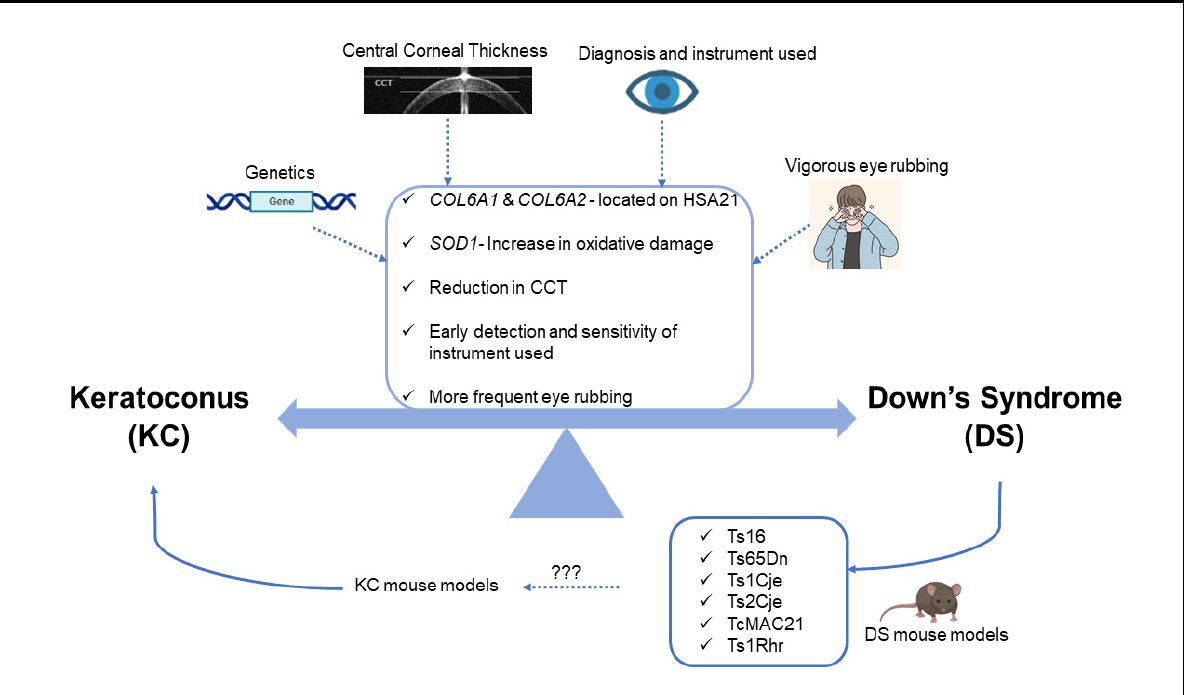
Figure 2. Schematic diagram summarizing the underlying relationship between KC and DS. Genes such as ( COL6A1 , COL6A2 , and SOD1 ), the measurement of CCT, habitual eye rubbing, screening DS patients for KC at an early age, diagnosis criteria, and type of instrument used in detecting KC could serve as potential connections between KC and DS. In addition, screening the ocular features of DS mouse models for KC could potentially provide mouse models of KC to better understand KC in DS.